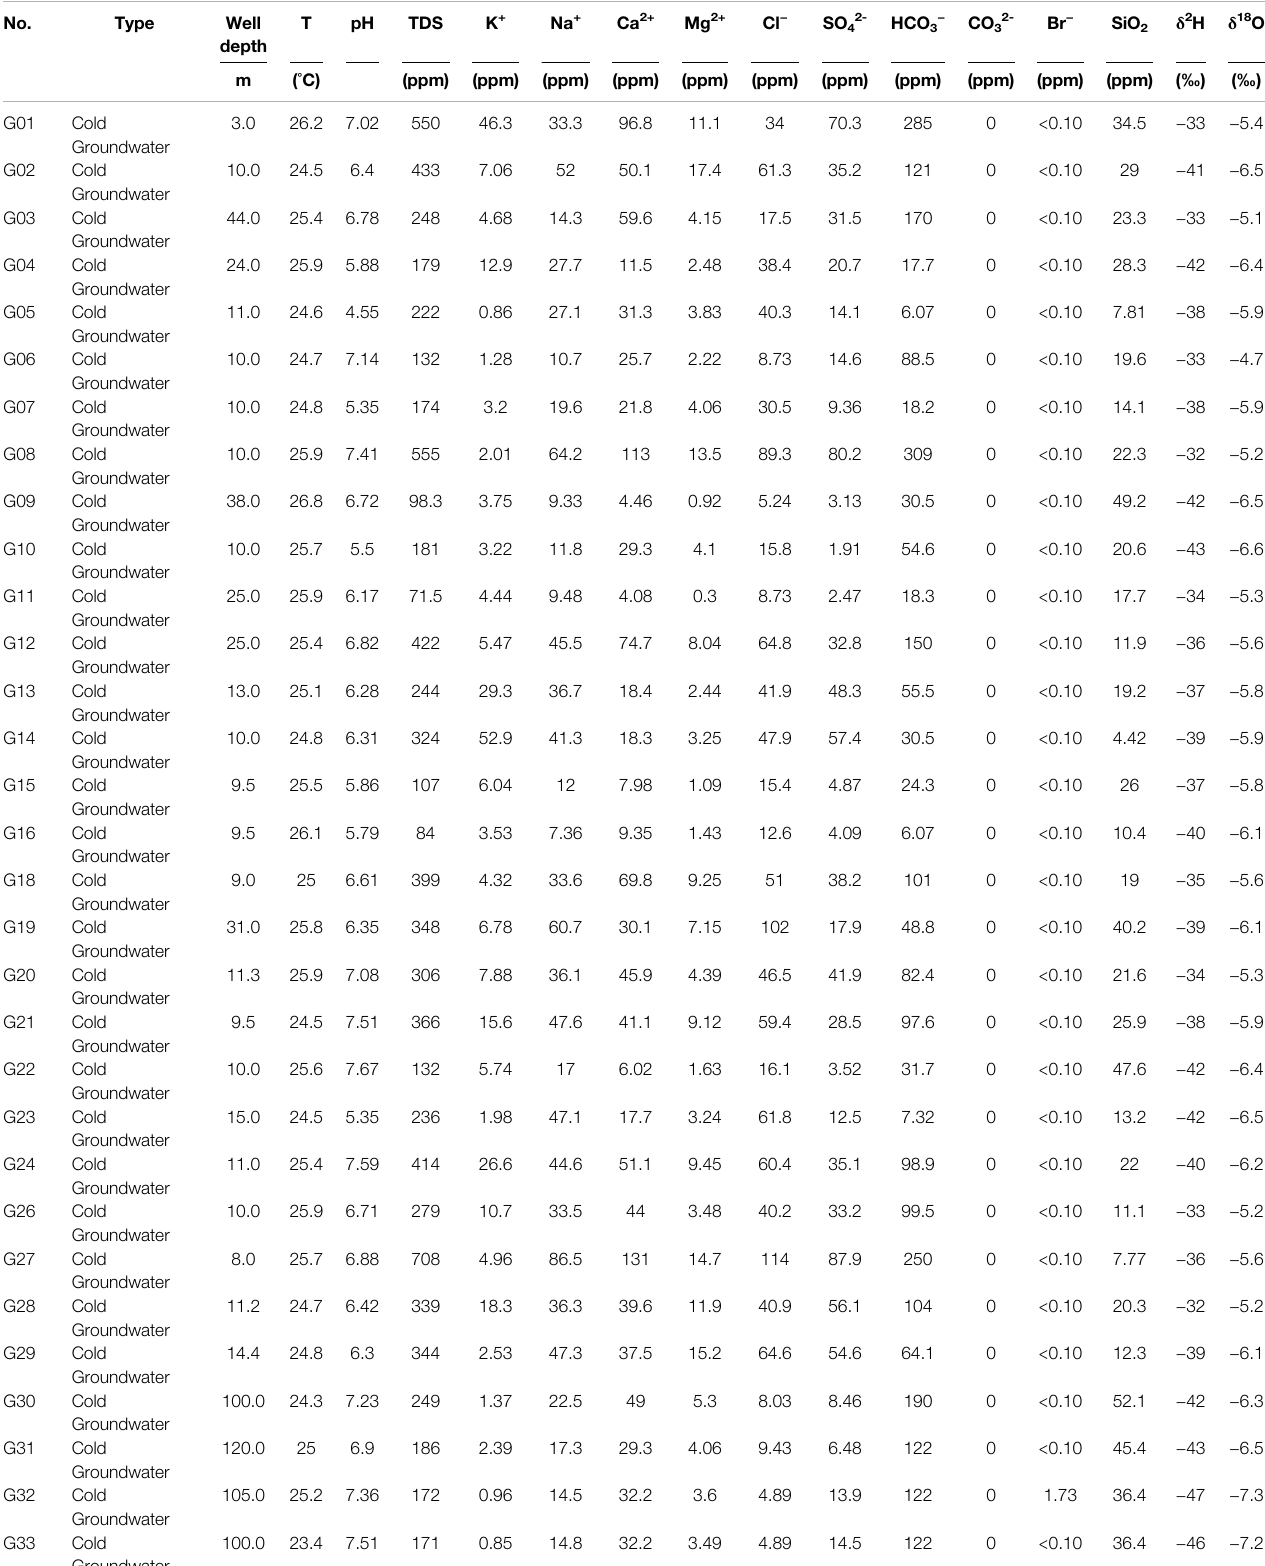
TABLE 1 | List of hydrochemical characteristics of groundwater in